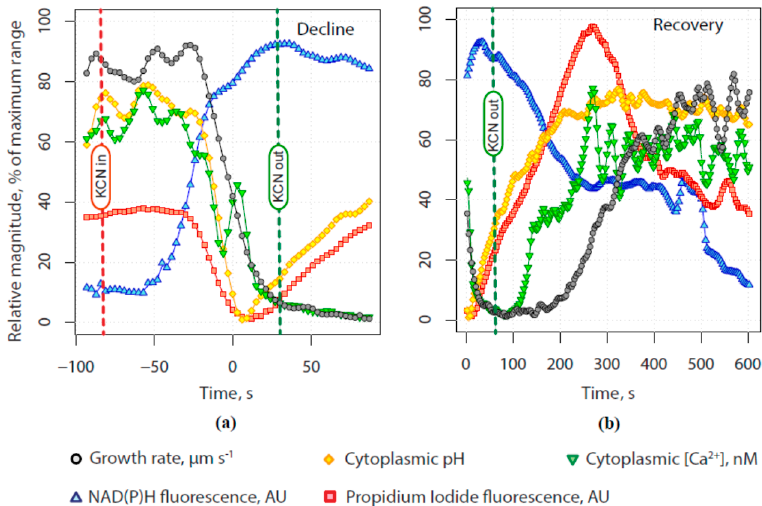
Figure 10. Comparison of all experiments using a common normalized time base derived from the decline ( a ) and subsequent recovery ( b ) in growth rate and relative magnitudes for each measured parameter. Red dashed line indicates the time that the flow of growth medium containing 200 µM KCN was started, and the green dashed line indicates the beginning of the flow of growth medium without KCN.